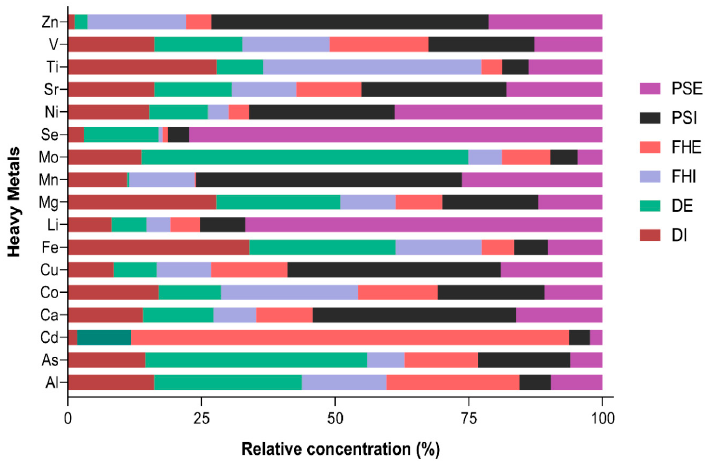
Figure 1. Heavy metal concentration levels (ppm) from the three WWTPs.